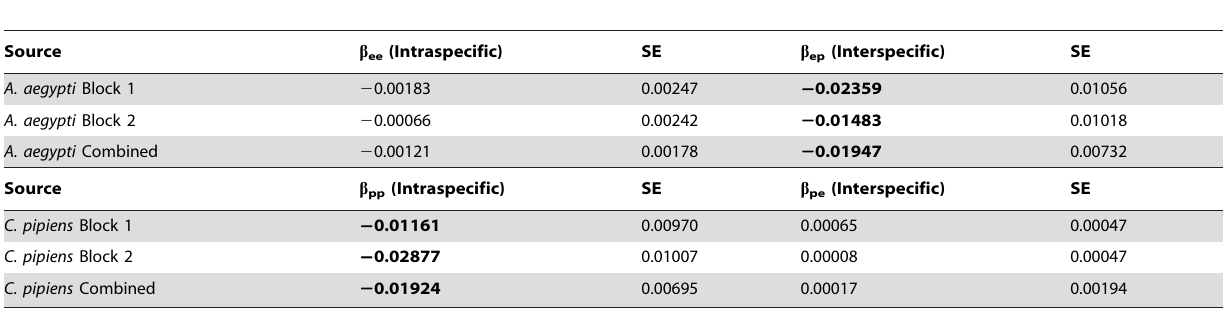
Table 7. Estimates of intra- and interspecific competitive effects for the pairwise response surface experiment Aedes aegypti vs. Culex pipiens